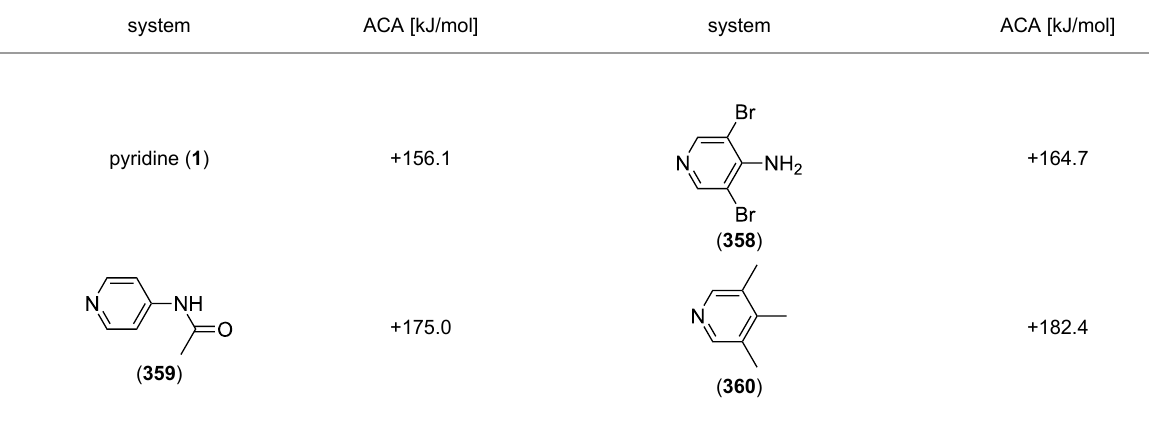
Table 13: ACA values of pyridines and 4-aminopyridines, ordered by increasing ACA